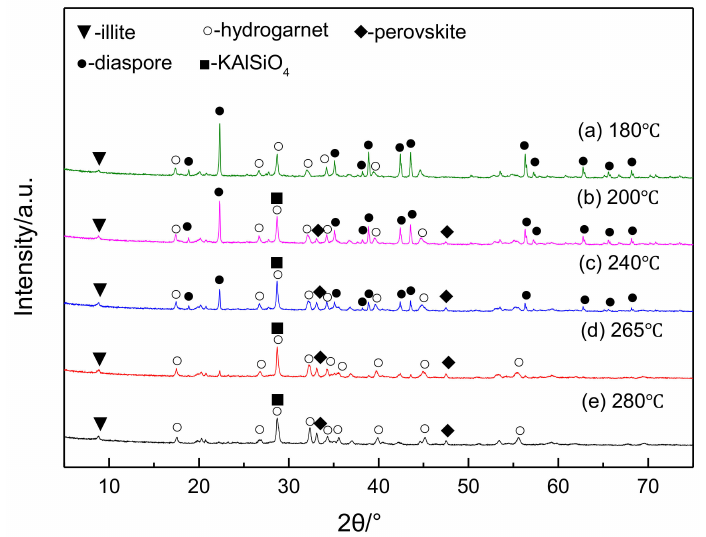
Figure 7. XRD patterns of red mud with different temperatures. (conditions: ρ (K 2 O) = 254 g/L, mass ratio of CaO/bauxite = 8%, t = 1 h).